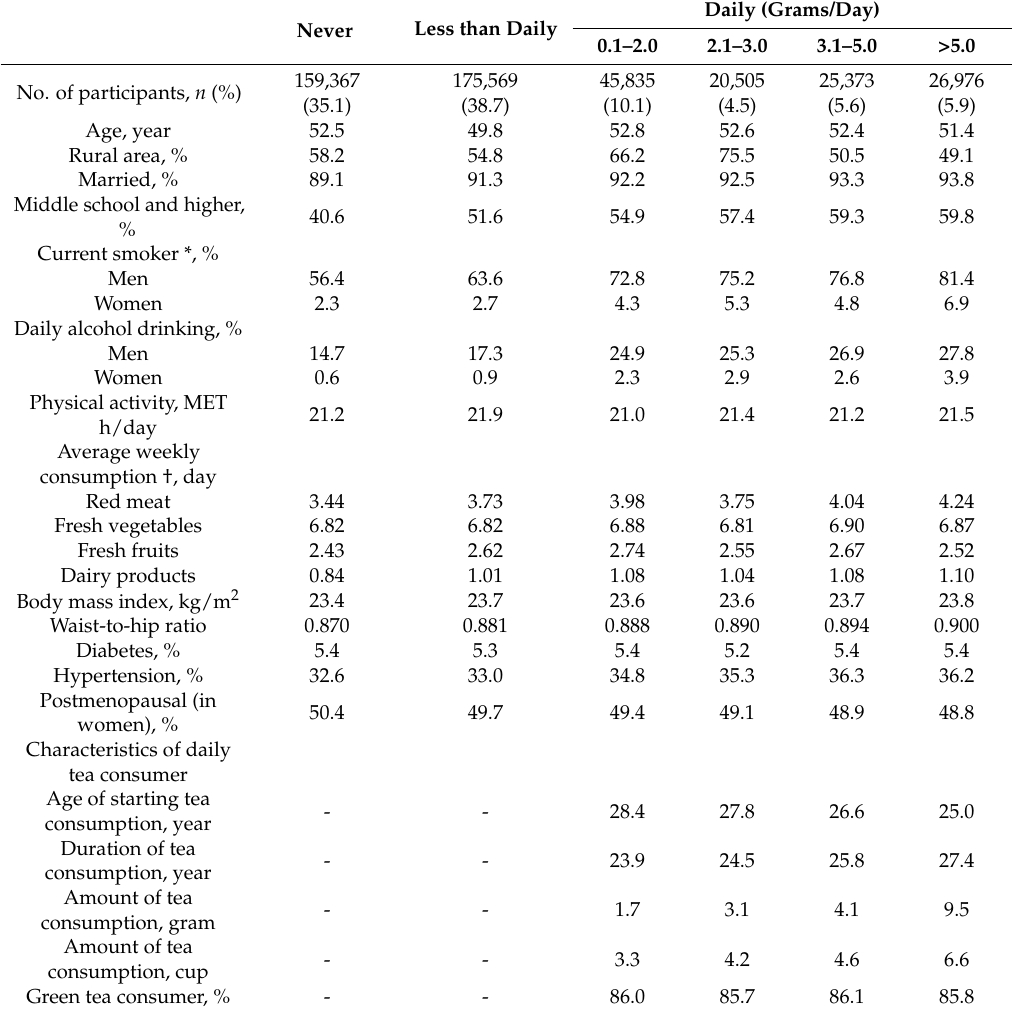
Table 1. Baseline characteristics of 453,625 study participants according to tea